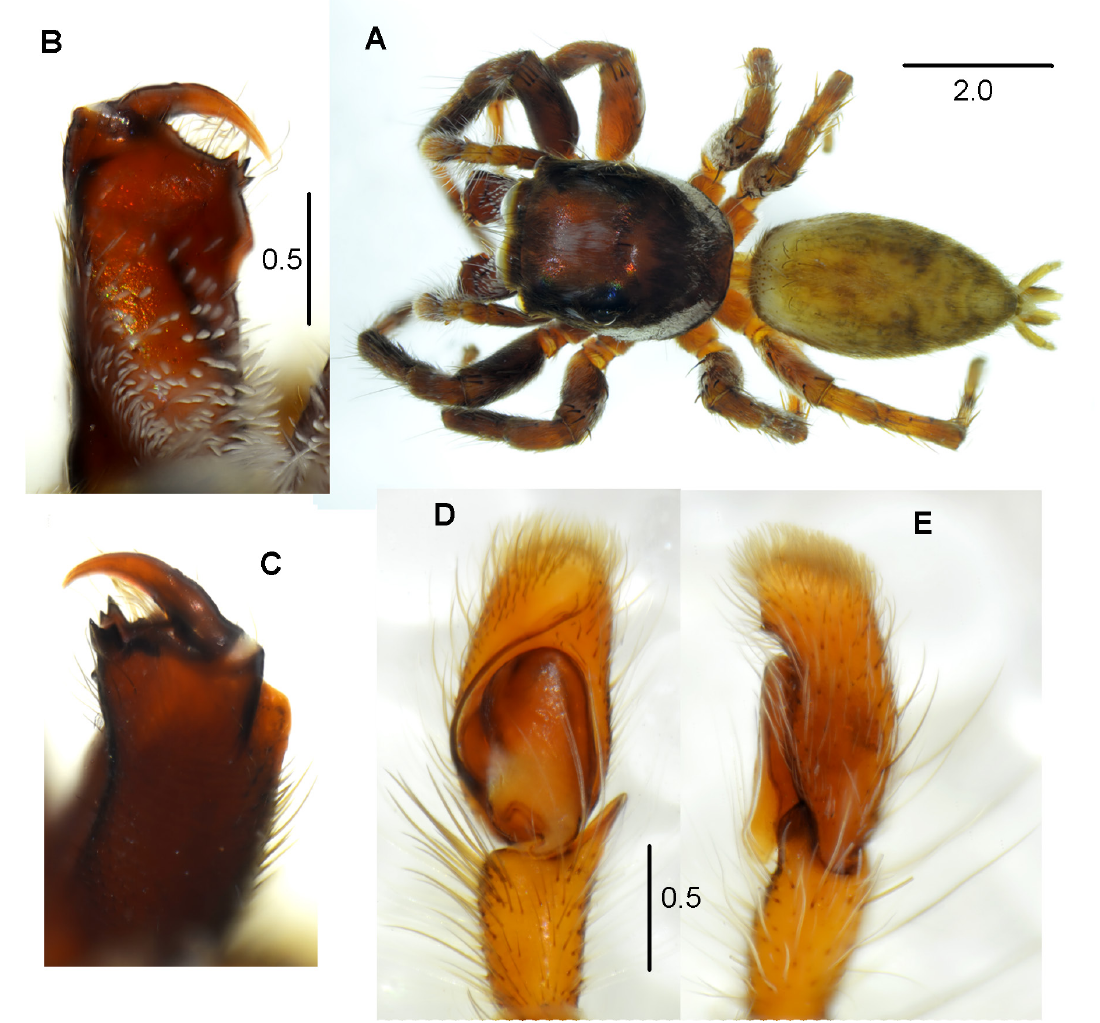
Fig. 76. Tusitala lutzi Lessert, 1927, ♂ (MNHN). A . Habitus, dorsal view. B . Chelicera, frontal view. C . Chelicera, ventral view. D . Palpal organ, ventral view. E . Palpal organ, lateral